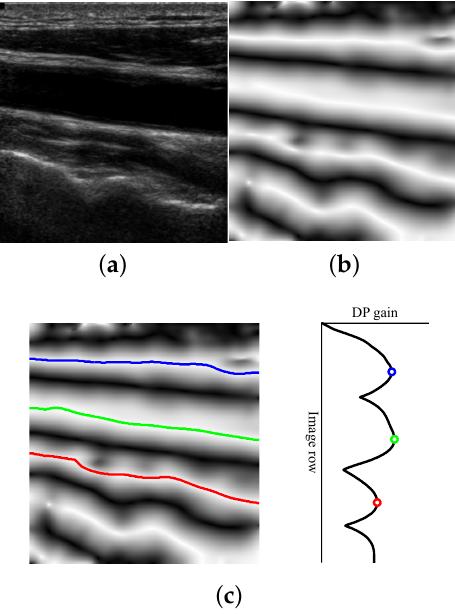
Figure 2. Illustration of the candidate lumen detection algorithm. ( a ) Input image; ( b ) symmetry map; ( c ) lumen candidates in the image and in the dynamic programming (DP) gain